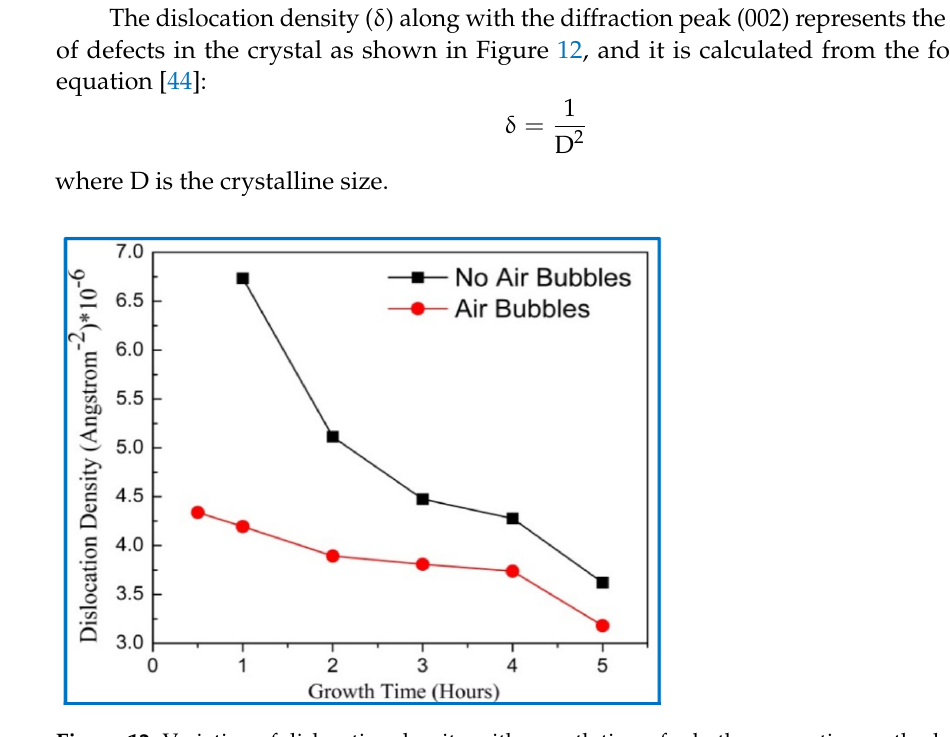
Figure 12. Variation of dislocation density with growth times for both preparation methods (conventional and modified) respectively.